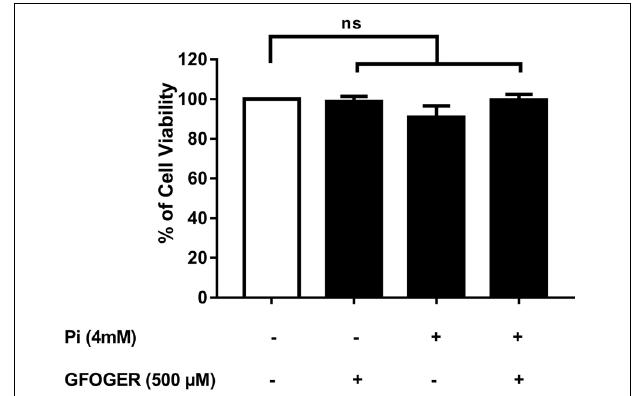
FIGURE 1 | Effect of GFOGER peptide on MOVAS-1 cells’ viability. MOVAS-1 cells were incubated with 500 µ M GFOGER peptide for 72 h in presence or absence of 4 mM Pi. Cell viability was measured using the WST-1 assay. Cell viability of untreated control cells was taken as 100%. Data are expressed as mean ± SEM of three independent experiments done in triplicate ( n = 3). Parametric one-way ANOVA